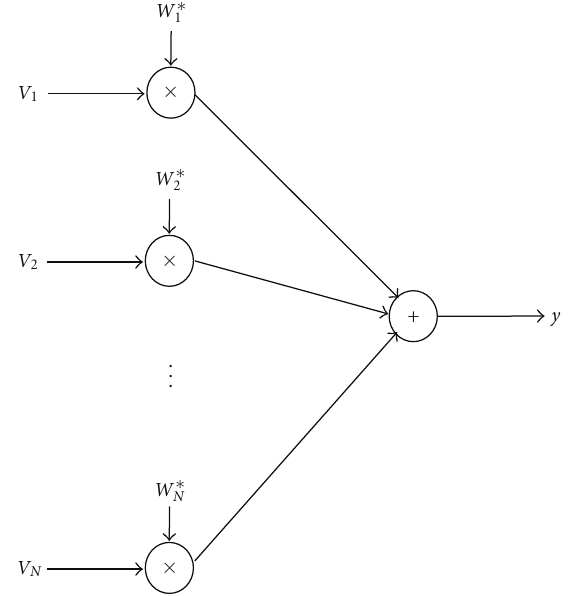
Figure 4: General smart antenna block diagram. The terminal voltages of the array elements are individually multiplied by the conjugated weights. The summation of the weighted voltages yields the smart antenna output y